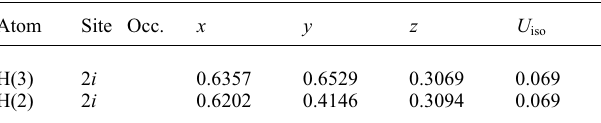
Table 2. Atomic coordinates and displacement parameters (in Å 2 )